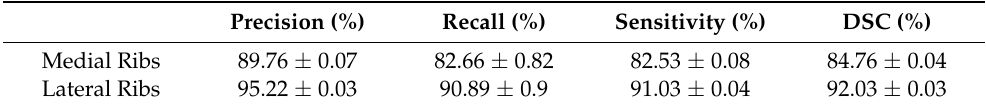
Table 3. Five-fold cross validation results of the medial and lateral ribs.